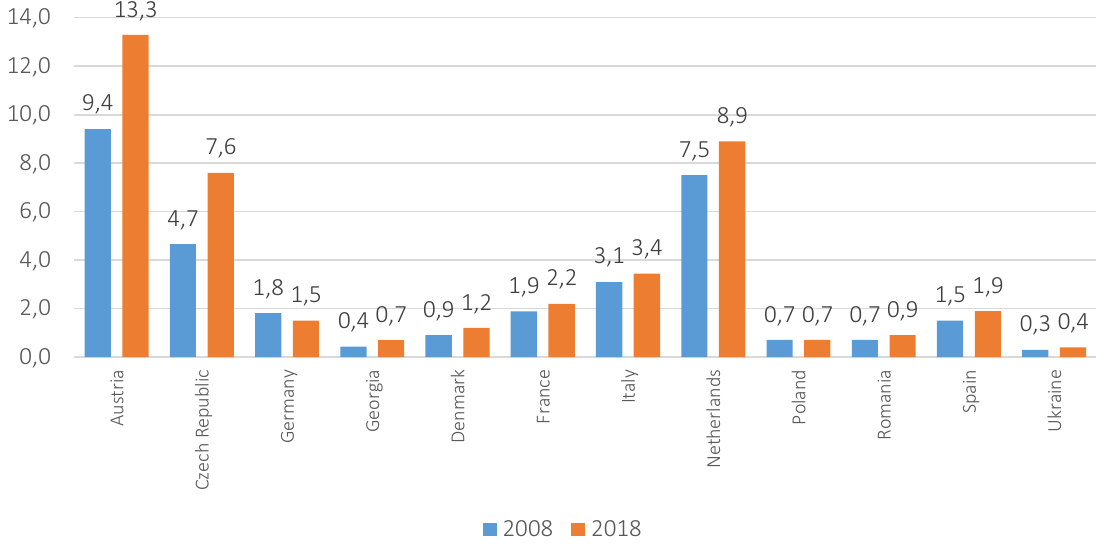
Figure 1. Land use efficiency, value added of agribusiness 2008 and 2018 (constant 2010)